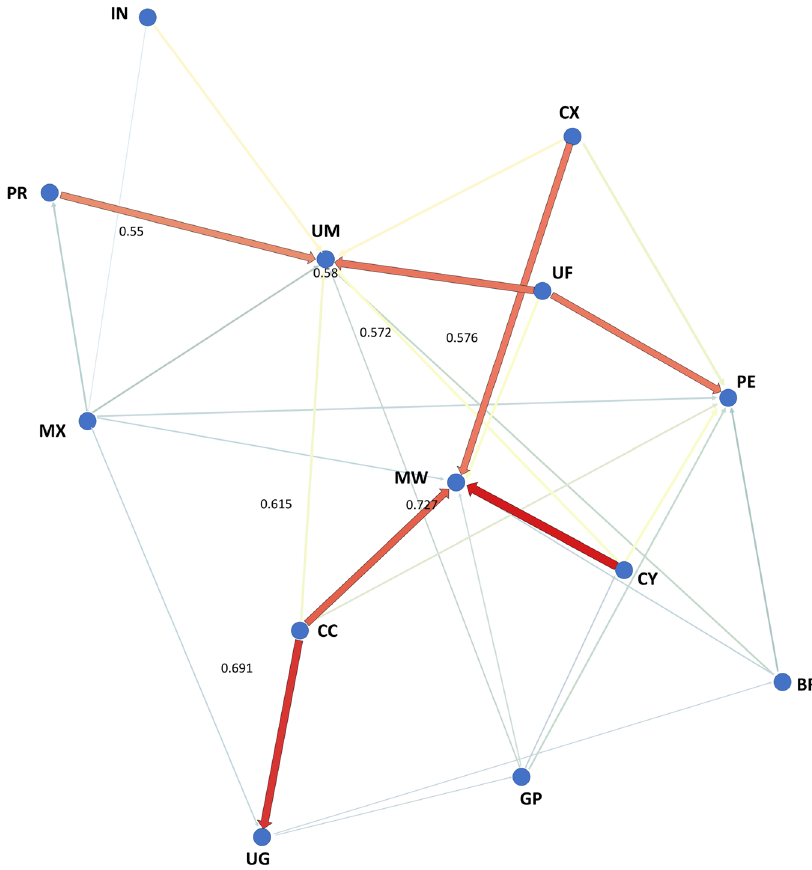
Fig. 7 divMigrate Analysis inferred directionality of gene fl ow between native and invasive Spodoptera frugiperda populations. Analysis using divMigrate to infer directionality of gene fl ow (i.e., relative directional migration) between New World native and Old World invasive Spodoptera frugiperda populations. The divMigrate analysis was run using the online server <https://popgen.shinyapps.io/divMigrate-online/> 122 . The analysis was performed with the G ST migration statistic of 127 and 128 at fi lter threshold = 3.0 and 1000 bootstrap replications to assess con fi dence with alpha value set at 0.05 (i.e., 95% con fi dence). Weighted values above 0.50 are indicated. Population codes are IN (India), PR (Puerto Rico), MX (Mexico), UG (Uganda), CC (China Cangyuan), CY (China Yuanjiang), CX (China Xinping), MW (Malawi), PE (Peru), GP (Guadeloupe), BR (Brazil-rCC), UM (USA Mississippi), and UF (USA Florida). High migration (i.e., gene fl ow; sensu Sundqvist et al. 124 ) is seen from all three Chinese populations into Malawi and from Cangyuan (CC) to Uganda (UG). High migration from Florida and from Puerto Rico into the Mississippi FAW population is also